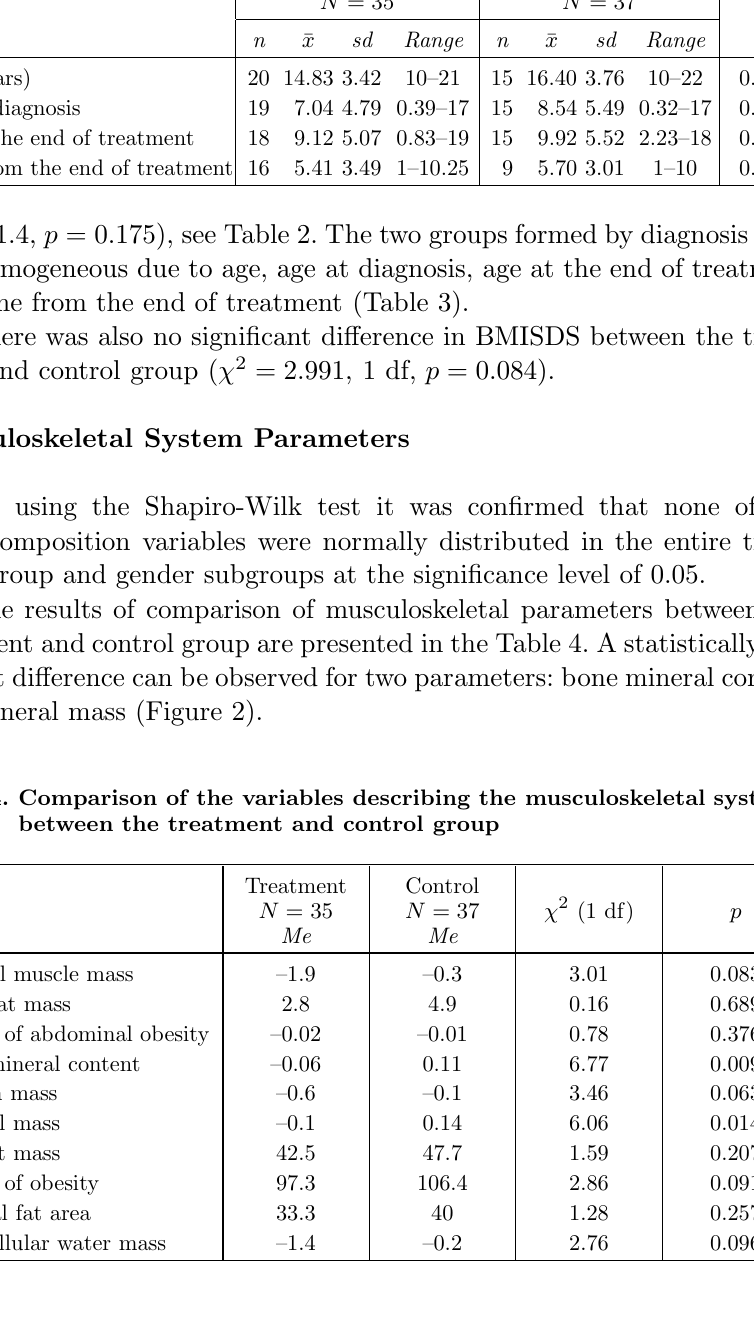
Table 3. Comparison of four variables connected with age in diagnosis groups Leukemia+Lymphomas